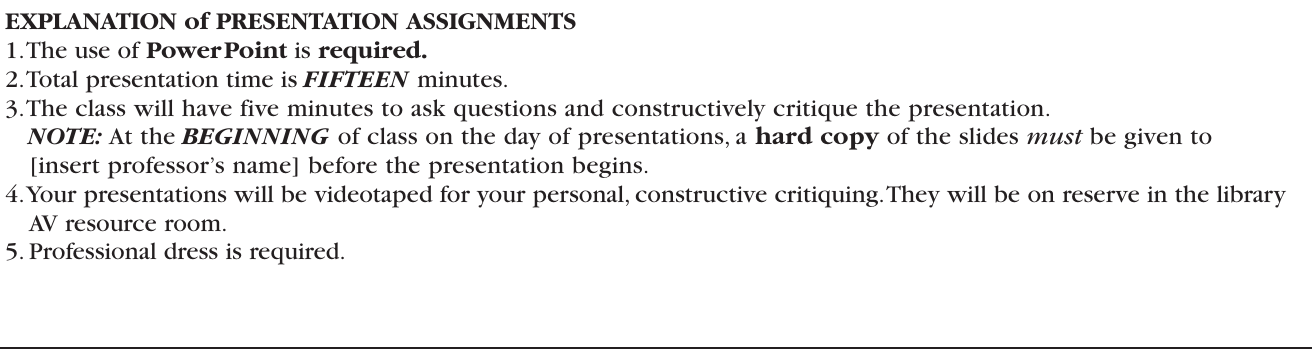
Figure 3. Sample Syllabus